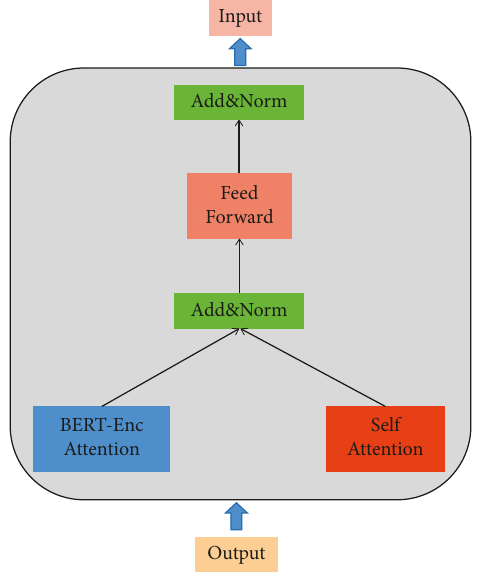
Figure 2: Encoder layer network